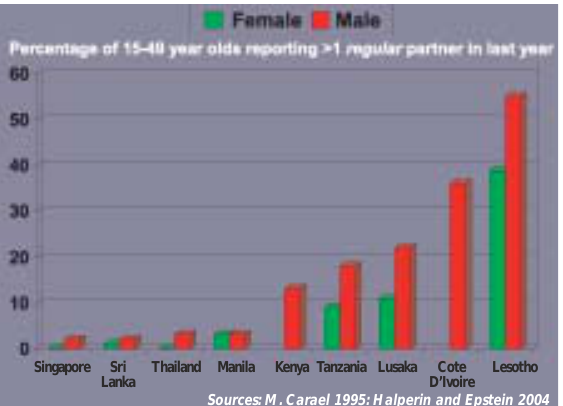
Fig. 2. Concurrent partnerships globally.